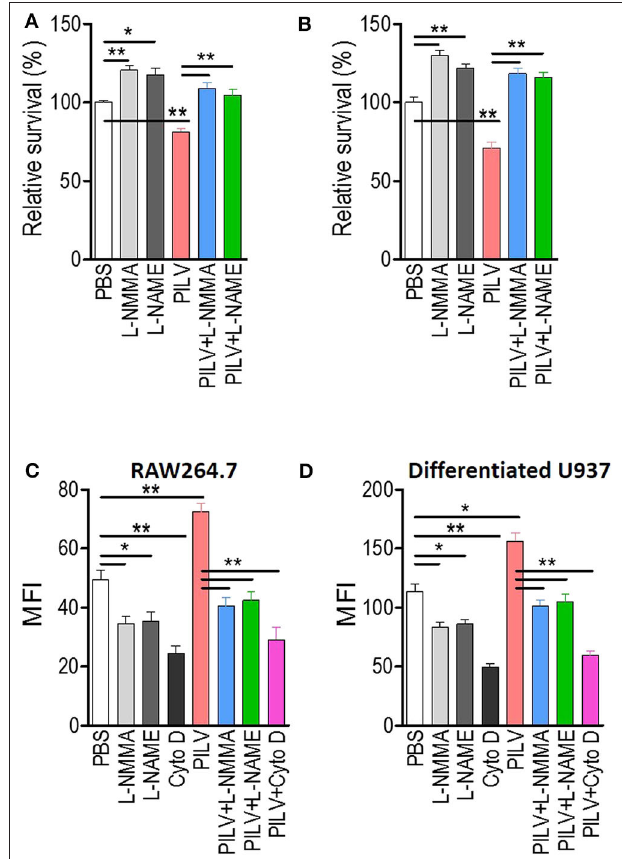
FIGURE 6 | PILV enhances opsonophagocytic killing (OPK) in a NO-dependent manner. (A,B) Relative survival about OPK of S. aureus in human (A) and mouse blood (B) without or with PILV. Human and mouse anticoagulated blood treated with heat-killed S. aureus Newman was incubated with live S. aureus Newman (2.5 × 10 6 CFU/ml blood for the human assay, 2.5 × 10 5 CFU/ml blood for the mouse assay) in the presence of PBS, NO inhibitors, PILV, or PILV plus NO inhibitors for 60min, and survival was measured ( n = 5). (C,D) Determination the phagocytosis of FITC-conjugated S. aureus Newman in RAW 264.7 (C) and U937-derived macrophages (D) without or with PILV. RAW264.7 or U937-derived macrophages were pretreated with PBS, NO inhibitors, PILV, or PILV plus NO inhibitors in a serum-starved medium for 6h and then were co-incubated with FITC-conjugated S. aureus for one more hour. Bacterial uptake was measured by flow cytometry. Data are represented as means ± SEM. * P < 0.05 and ** P < 0.01 (two-tailed Student’s t